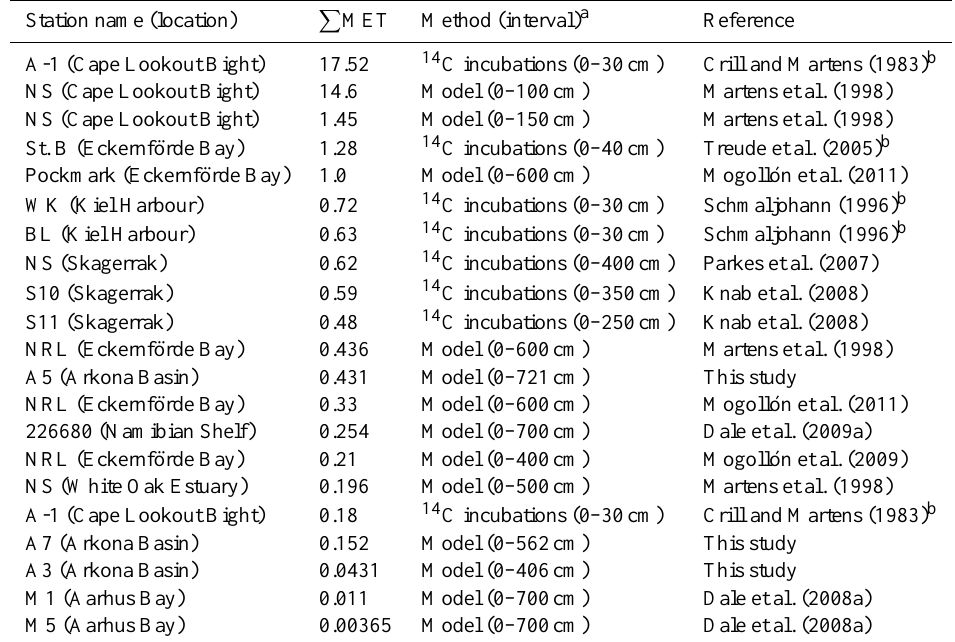
Table 4. Depth-Integrated methanogenesis rates ( P MET) in shelf sediments (molm − 2 yr − 1 ).